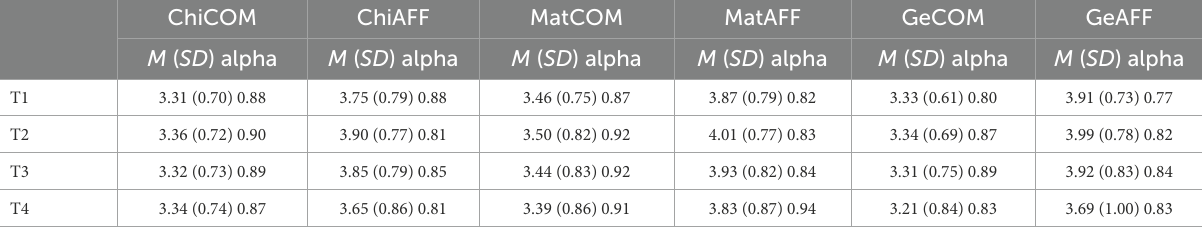
TABLE 2 Descriptive statistics and reliability of